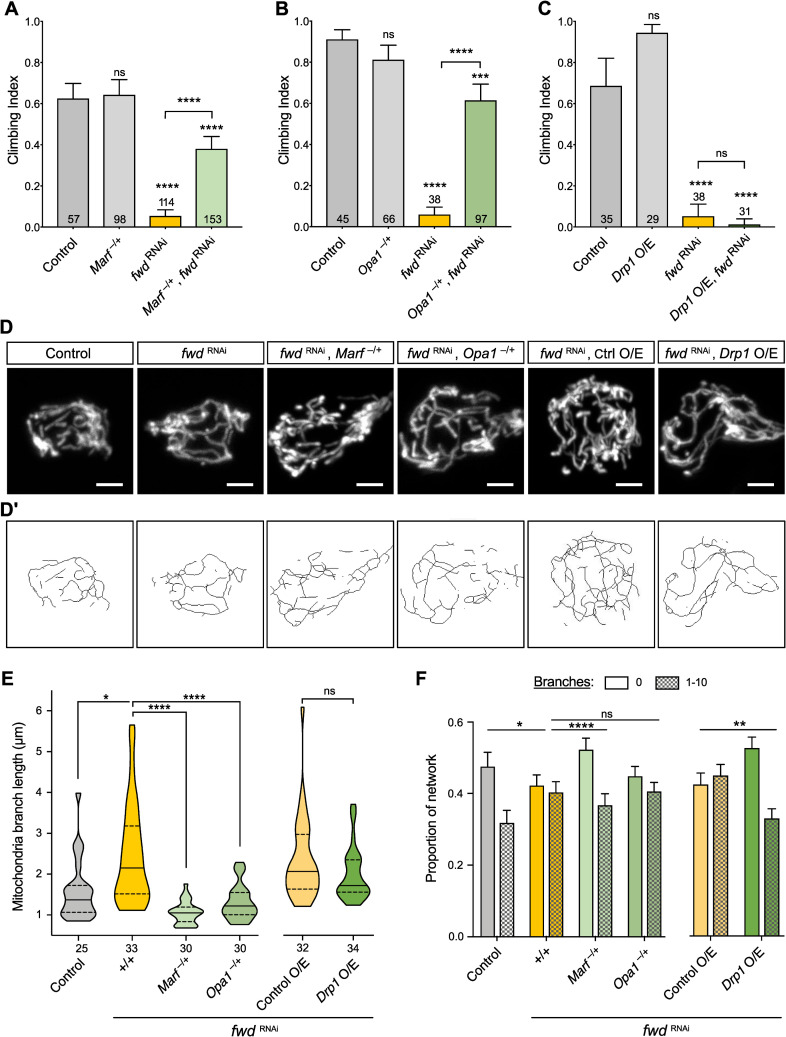
fwd genetically interacts with mitochondrial fission/fusion factors.(A-C) Climbing assay of fwd RNAi alone or in combination with heterozygous Marf or Opa1 mutations or transgenic overexpression of Drp1. Transgenic expression was mediated via da-GAL4. Charts show mean ± 95% confidence interval (CI); number of animals analysed is shown in each bar. (D) Confocal microscopy analysis of mitochondrial network morphology (mitoGFP) in neuronal cell bodies from larval ventral ganglion of control, fwd RNAi alone and in combination with heterozygous Marf or Opa1 mutations or transgenic overexpression of Drp1. Image shows a projected z-stack. Scale bar = 2 μm. (D’) Skeletonised image of mitochondrial network used for quantification. (E) Quantification of median mitochondrial branch length per cell. Violin plot indicating median (solid horizontal line) and quartiles (dashed lines). Significance was analysed by Mann-Whitney test (left) or unpaired t-test (right). The number of cells analysed is indicated below each plot. (F) Plot of the proportion of individual mitochondria (0 branches) and connected mitochondria (1–10 branches) quantified per cell. Significance was calculated by Kruskal-Wallis test with Dunn’s post-hoc correction for multiple comparisons (left) or t-test (right). Comparison is against the control unless otherwise indicated; * P<0.05, ** P<0.01, *** P<0.001, **** P<0.0001; ns, non-significant. Full genotypes are given in S1 Table.